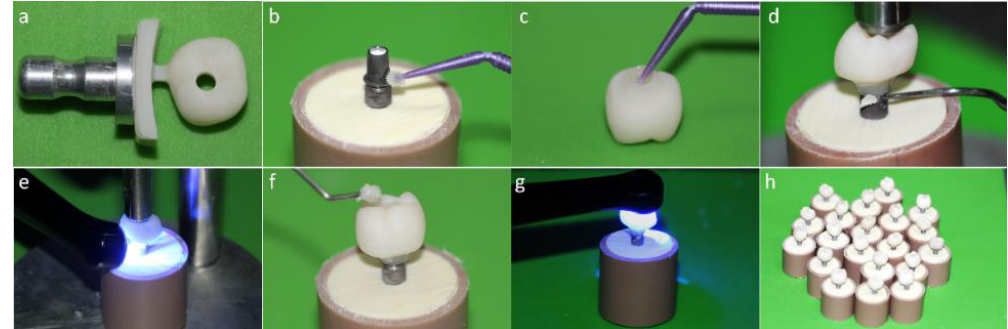
Figure 3. ( a ) Monolithic crown machined in an implant solution block; ( b ) Alloy primer application in the titanium base (Tibase); ( c ) Silanization of the internal surface of the crown; ( d ) Removal of excess cement; ( e ) Light curing; ( f ) Sealing of the screw access hole with composite resin; ( g ) Monolithic crown with perforation; ( h ) (MP) group crowns